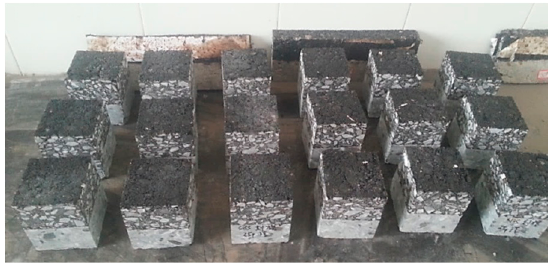
Figure 4. Specimens for the direct shear test with different interfacial treatment.